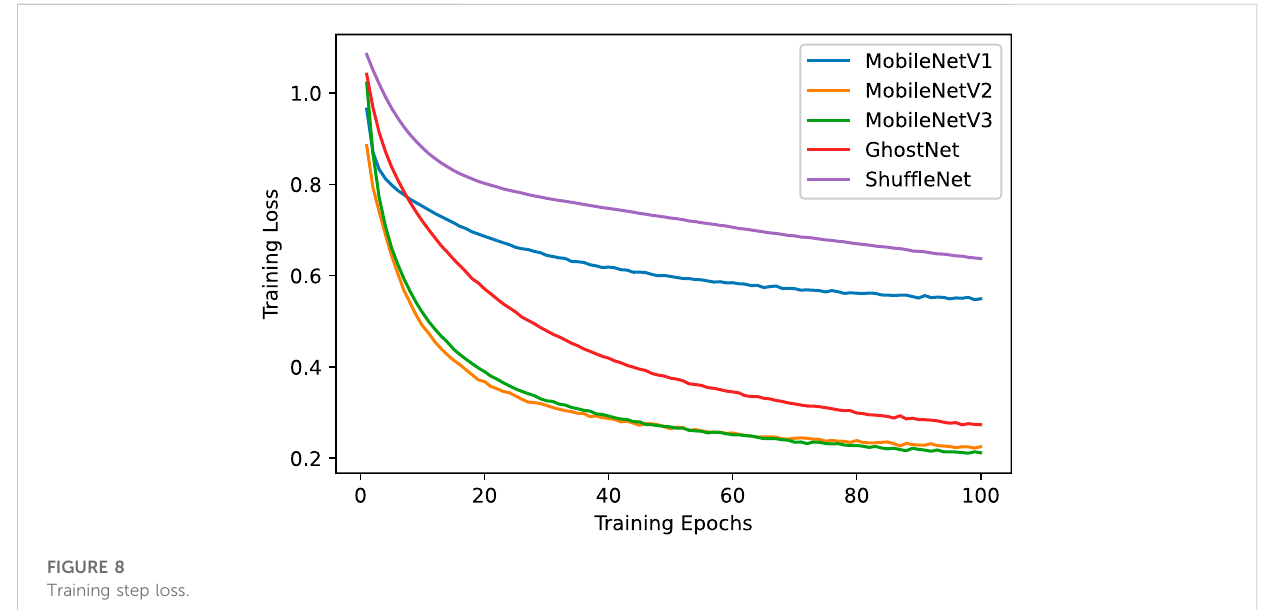
FIGURE 8 Training step loss.